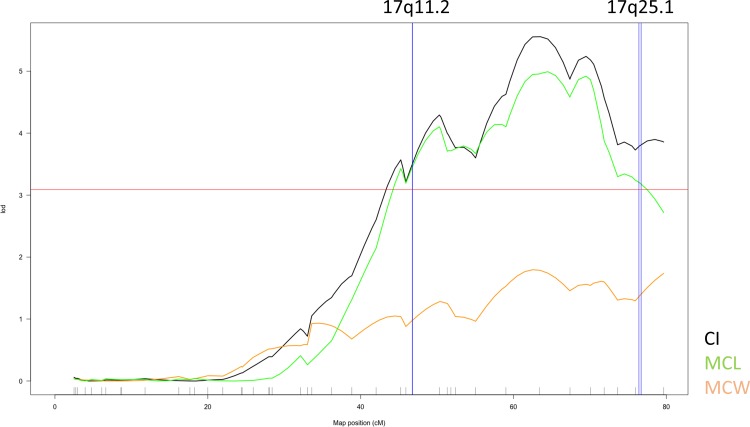
Positive linkage result in mice corresponding to two human GWAS signals.Traits are indicated by color: MCW (orange), MCL (green) and CI (black). The two corresponding human hits (17q11.2 and 17q25.1) are indicated by blue vertical lines. The horizontal line represents the permutation-based empirical threshold for genome-wide statistical significance.